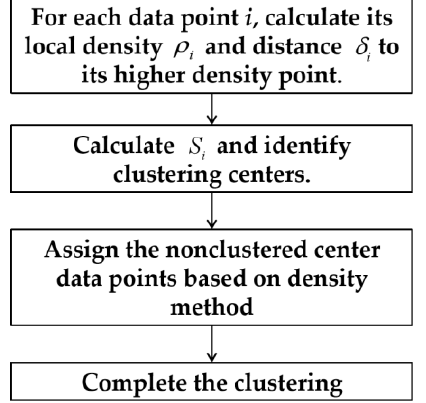
Figure 3. Flow chart of density peak clustering.